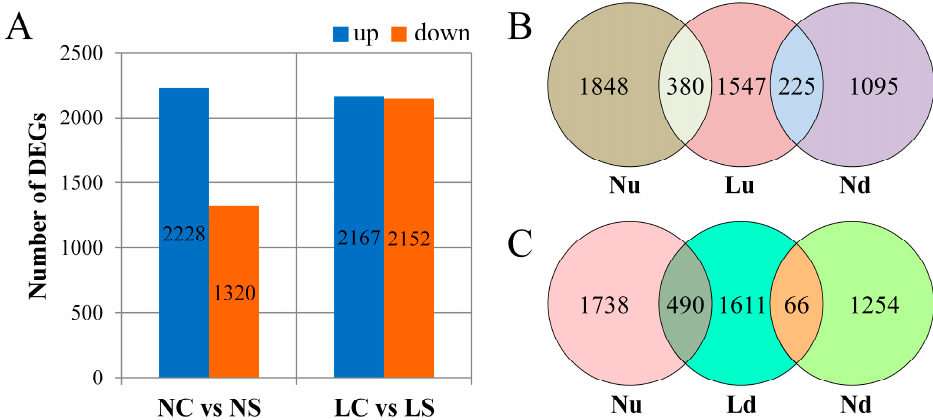
Figure 2. Di ff erentially expressed genes (DEGs). ( A ) Number of DEGs between SMV infection and CK. ( B , C ) Venn diagrams showing the number of overlaps in DEGs. NS and NC refer to SMV infection and control, respectively, under normal light, while LS and LC refer to SMV infection and control, respectively, in the shade. Nu and Nd refer to upregulated genes and downregulated genes between NC vs NS. Lu and Ld refer to upregulated and downregulated genes between LC vs